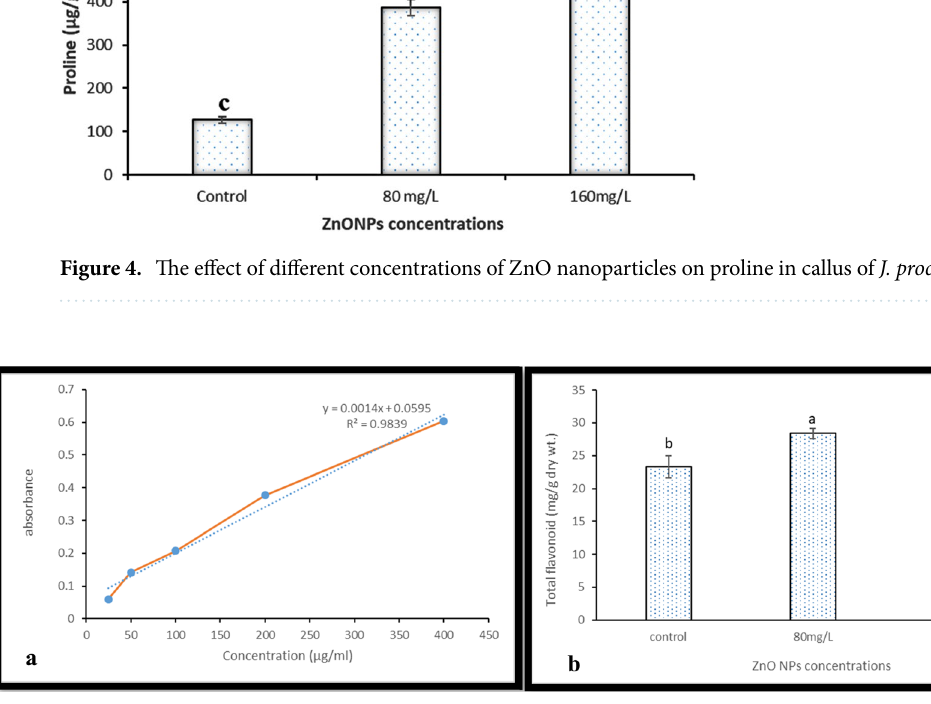
Figure 5. ( a ) Quercetin standard curve ( b ) the impact of Zno nanoparticles on total flavonoids (mg/g